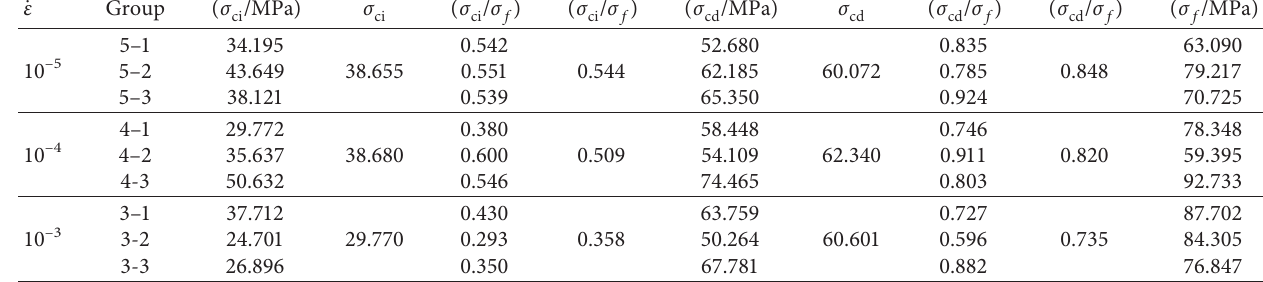
Table 1: Stress characteristic values with different strain rates.